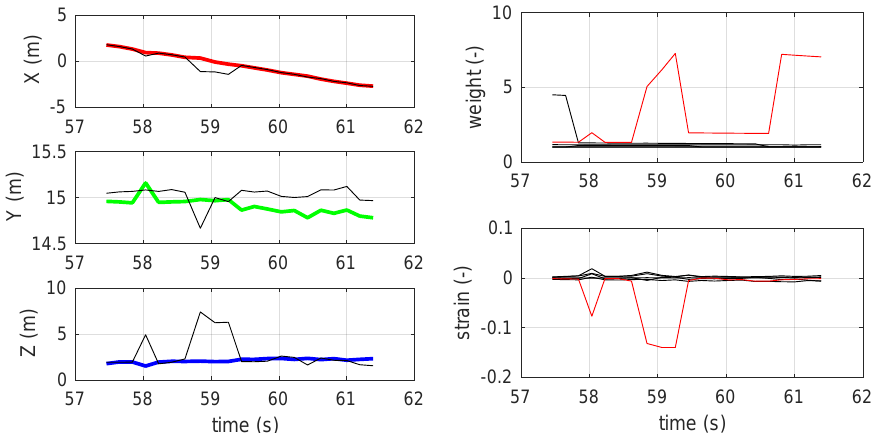
Figure 8. Left : Coordinates detail around the spike in the original trace (blue), which is marked with a thicker line in Figure 5 (close to anchor 4). Right : Strain and weight detail around the spike in the original trace (blue), which is marked with a thicker line in Figure 5 (close to anchor 4). The red line is related to anchor 6; other anchors are black.